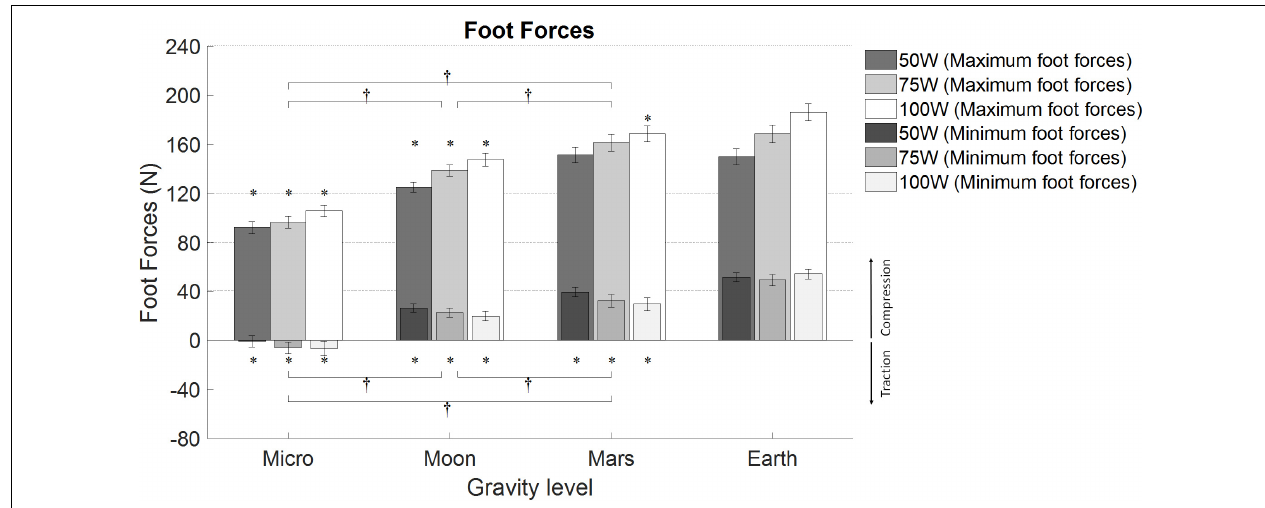
FIGURE 7 | Average minimum and maximum foot forces (12 subjects, mean ± SE at different workload intensities for each of the altered-gravity environments (Microgravity 6 ◦ HDT, Moon 9.5 ◦ HUT, Mars 22.3 ◦ HUT, Earth upright). The figure highlights significant differences between altered-gravity conditions Microgravity, Moon, and Mars (pairwise comparisons after a 2-factor repeated measures ANOVA with Bonferroni correction, † significantly different at p < 0.05). Additionally, significant differences compared to Earth are also included ( ∗ paired t -test, p < 0.05). For clarity, pairwise comparisons between workload levels are not shown.